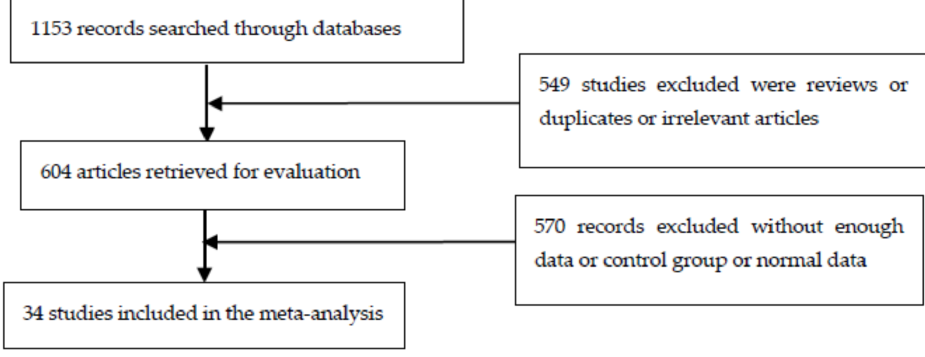
Figure 1. Flow chart of study selection.